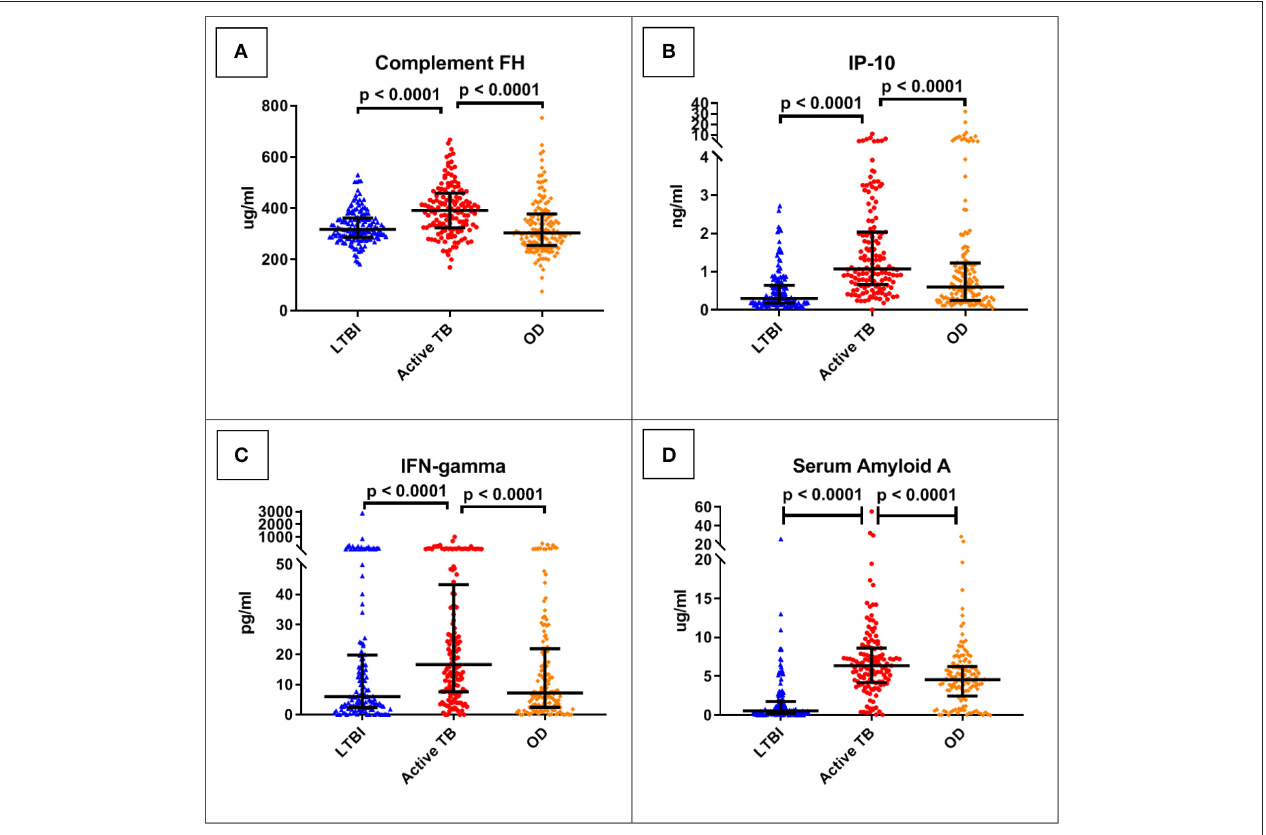
FIGURE 2 | Serum concentrations of the top four protein biomarkers (panels A–D ) by clinical group. Scatter-dot plots show results for each patient in the ILULU-TB cohort, regardless of HIV status or site. P -values are 1-sided and derived from Mann-Whitney tests. Error bars represent medians and interquartile ranges. IP-10, IFN-gamma-inducible protein 10; IFN-gamma,